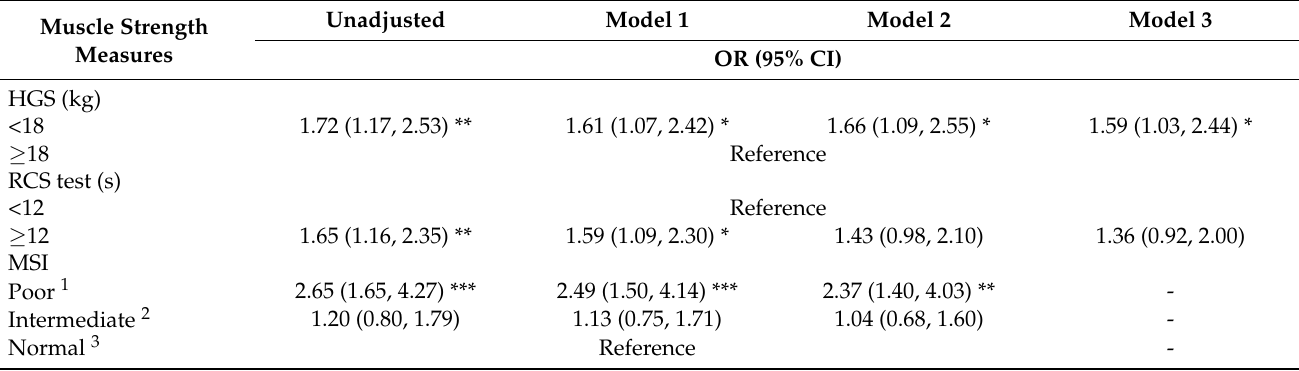
Table 2. Associations between HGS, RCS, and the muscle strength index (MSI) with diabetes status (n = 1170). Hierarchical binary logistic regression was performed with two categories (diabetes vs. non-diabetes). Results were presented as odds ratio (OR) and 95% confidence intervals (95%